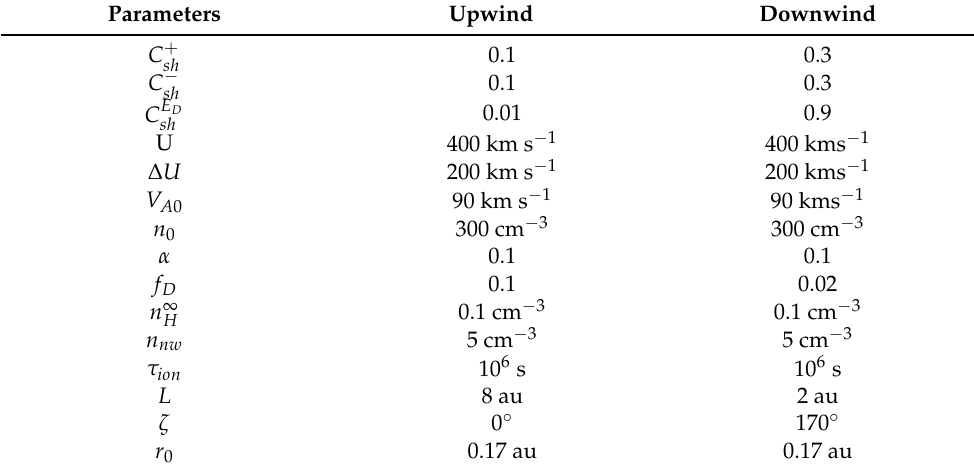
Table 2. Model parameters. In the downwind direction, the values for L = 2 au and ζ = 170 ◦ are obtained by fitting the hydrogen neutrals by exp ( − L ζ /sin ζ ) along the trajectory of Pioneer 10 [118].